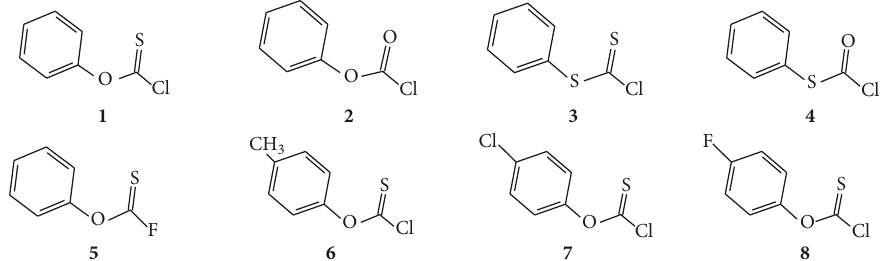
F 1: Molecular structures of phenyl chlorothionoformate ( 1 ), phenyl chloroformate ( 2 ), phenyl chlorodithioformate ( 3 ), phenyl chlorothioformate ( 4 ), phenyl �uorothionoformate ( 5 ), p -tolyl chlorothionoformate ( 6 ), p -chlorophenyl chlorothionoformate (7), and p - �uorophenyl chlorothionoformate ( 8